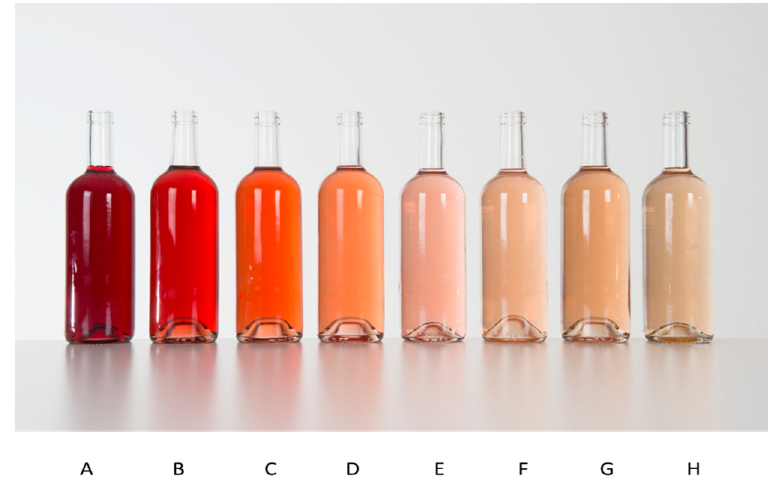
Figure 1. Photos of the eight wines selected and anonymised, representing a wide range of shades for rose wines on the market, based on the Colour Chart from the Centre du Rose ( ® ) [44]. A–H: 8 shades of ros é wines (from the “garnet” shade to the “lychee” shade). The sample of wines ranged from the “garnet” shade for Wine A to the “lychee” shade for Wine H, via the “apricot” shade for Wine D and “salmon” for Wine E. These terms, describing the colours observed, were at no point shared with the consumers.